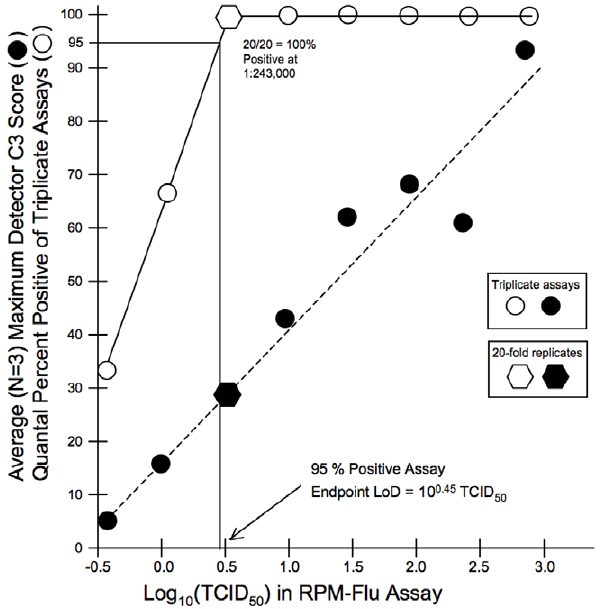
Figure 5. Limit of Detection (LoD) determination for seasonal A/H1N1 strain BRD10622. Neat stock of cell culture lysate (3.16 6 10 ˆ 7 TCID 50 /ml) was diluted 1:1,000 in cell culture media. Triplicates at this dilution, and at serial three-fold dilutions to 1:2,187,000 were individually extracted and subjected to RPM-Flu assay. Black circles indicate average of the maximum C3 Score (from either HA1, NA1 or M(H1N1) detector tiles) at each dilution, plotted against log 10 TCID 50 input per assay. Open circles represent the quantal percentage of positive assays (out of three) at each dilution tier. The open and black hexagons correspond to a dilution tier at which 20-fold replicates were assayed to demonstrate the 95% endpoint LoD, in this case corresponding to single assay input of about 3 TCID 50 .